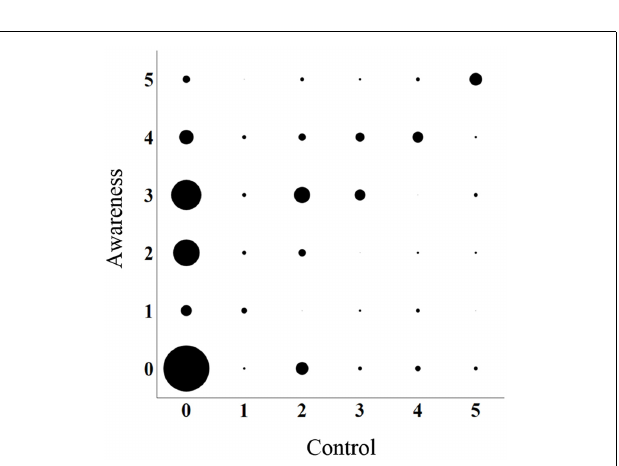
FIGURE 2 | The size of the black circles represents the number of participant responding to both questions (awareness and control) in AwareContQuest. Awareness and control were both evaluated on the same 6-point rating scale (0: never, 1: once, 2: less than once a year but more